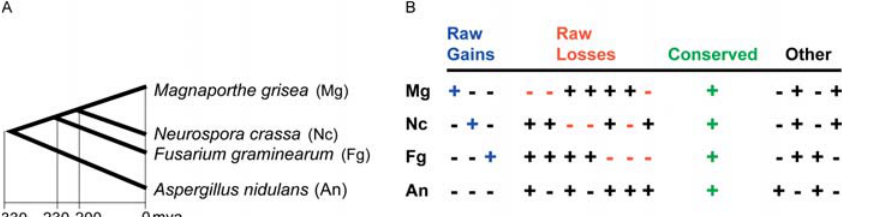
gence from Taylor et al. (1999), Berbee and Taylor (2000), and Heckman et al. (2001).(B) Classification of intron presence ( þ ) and absence ( (cid:1) ) patterns across the four fungal species. A blue ‘‘ þ ’’ indicates a raw intron gain in the corresponding organism, a red ‘‘ (cid:1) ’’ indicates a raw intron loss in the corresponding organism, a green ‘‘ þ ’’ indicates a conserved intron, and all other introns are indicated in black. DOI: